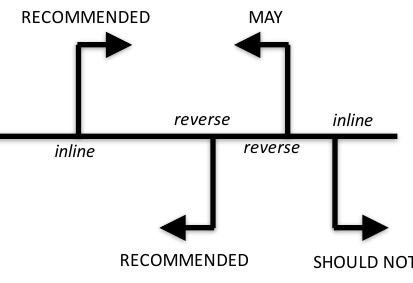
Figure 10: Use of glyph orientation to indicate inline vs. reverse complement direction.